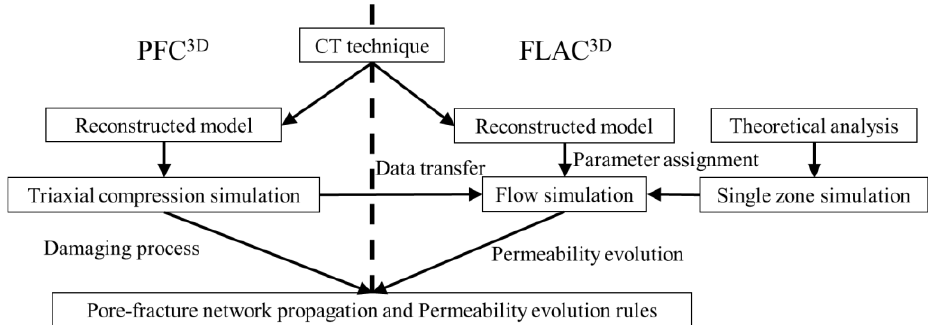
Figure 6. Flowchart illustrating the specific coupling between PFC 3D and FLAC 3D . Both models are set-up in parallel by duplicating the microstructure obtained from CT. Size of particles (diameter) corresponds to size of zones (edge length) in the continuum- based model. PFC 3D is used to simulate the microcrack/microfracture evolution. FLAC 3D is used to simulate the gas flow. At predefined time step intervals, crack data are transferred from PFC 3D to FLAC 3D . Corresponding zones in FLAC 3D are assigned with hy- draulic parameters based on the crack data and flow-only numerical simulations are per- formed to obtain the permeability evolution (one-way coupling).